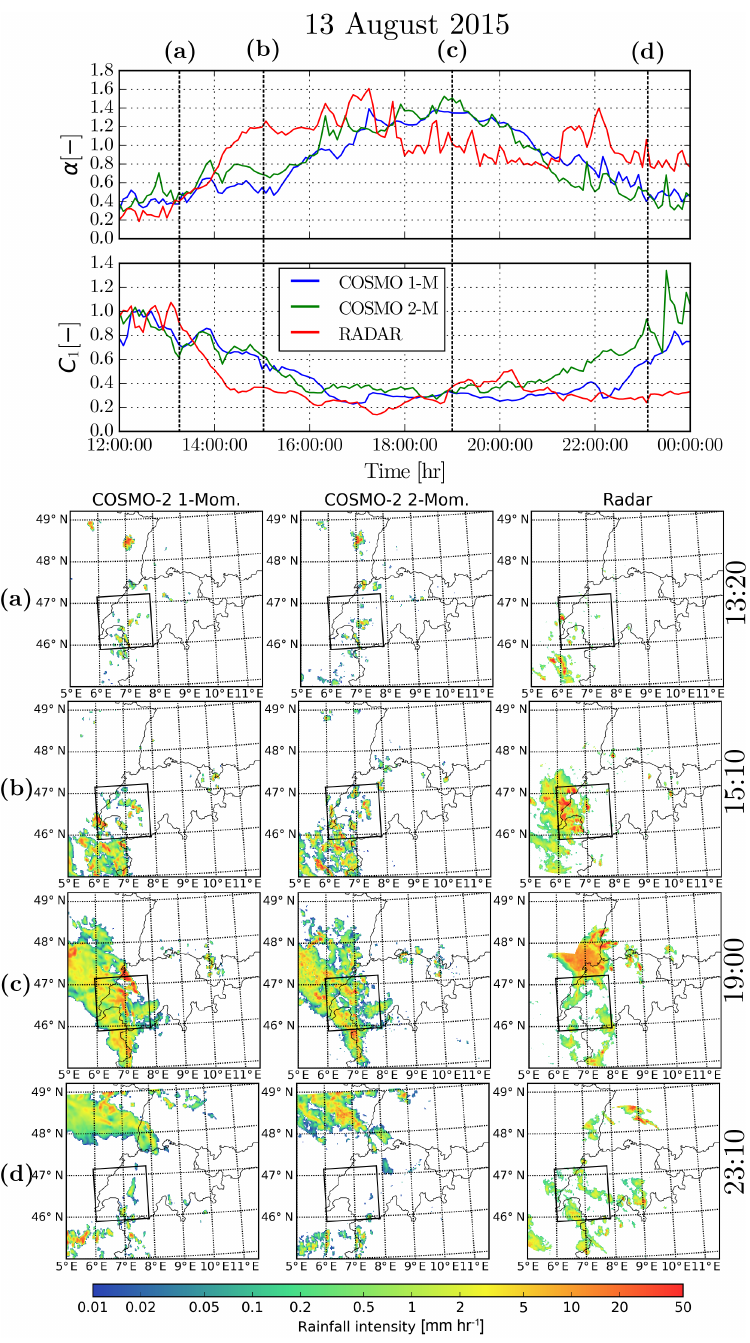
Figure 10. The upper panel displays the α and C 1 time series during the third event. The lower panels (a, b, c, d) show the spatial structure of simulated and observed precipitation fields during four different time steps (13:20, 15:10, 19:00 and